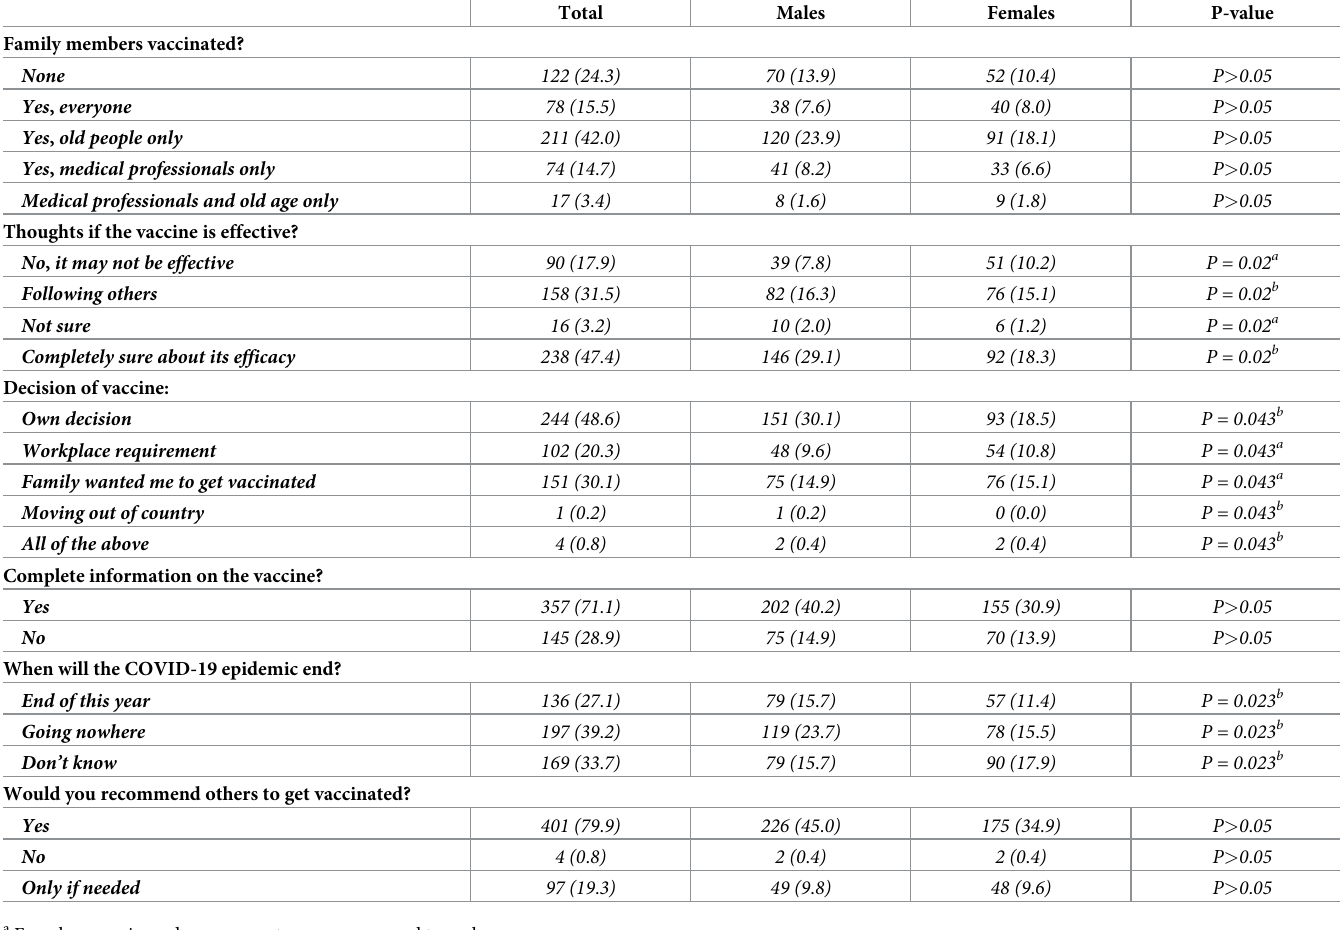
Table 3. Perception towards vaccine.